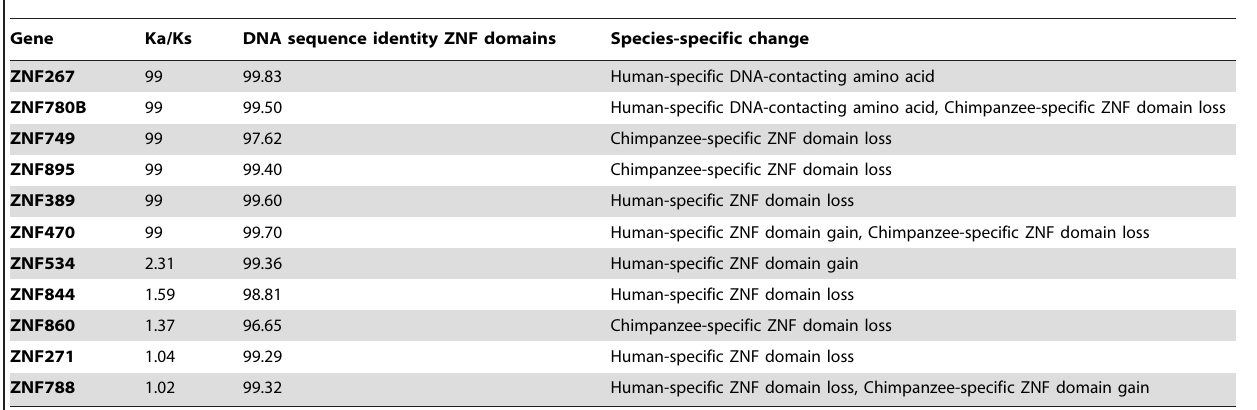
Table 4. KZNF genes with human or chimpanzee specific changes in ZNF domains and Ka/Ks . 1.